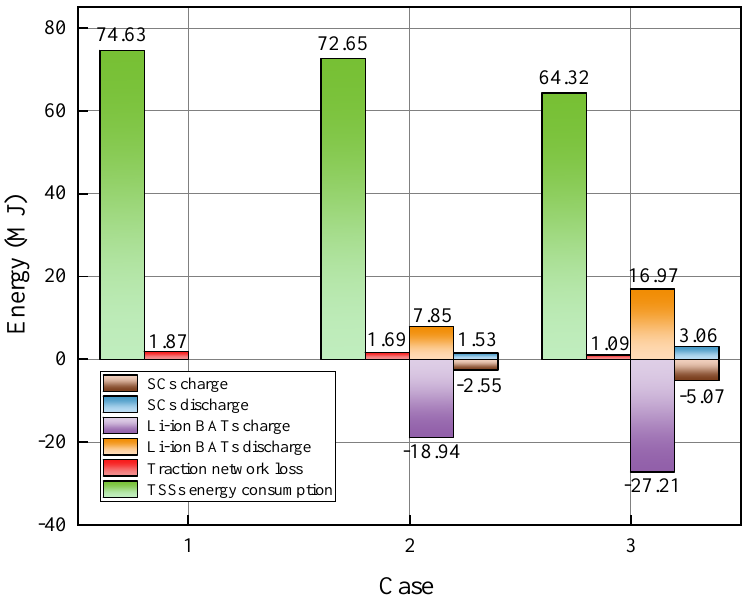
Figure 7. The energy flow of all the components in cases 1–3.